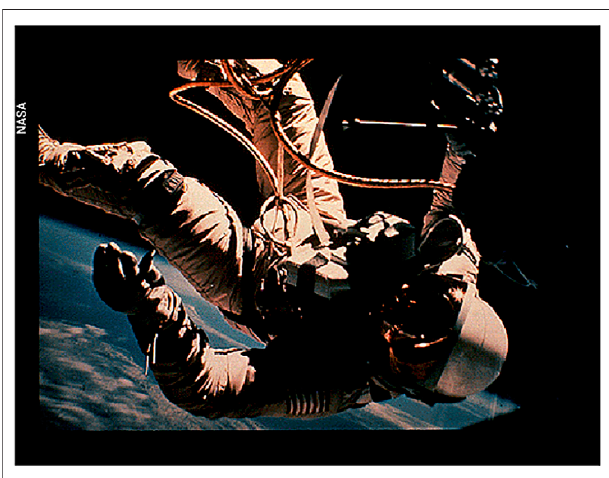
FIGURE 9 | Titan Centaur launch. Credit: NASA. FIGURE 10 | Astronaut in space. Credit: